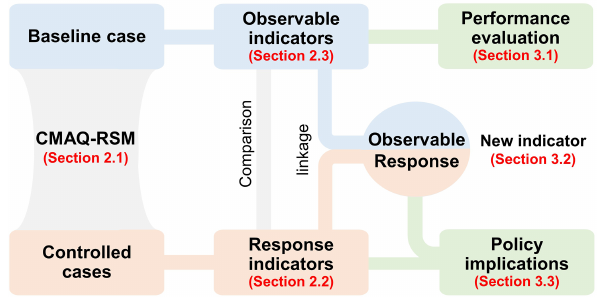
Figure 1. Flow of observable response indicator development and application.